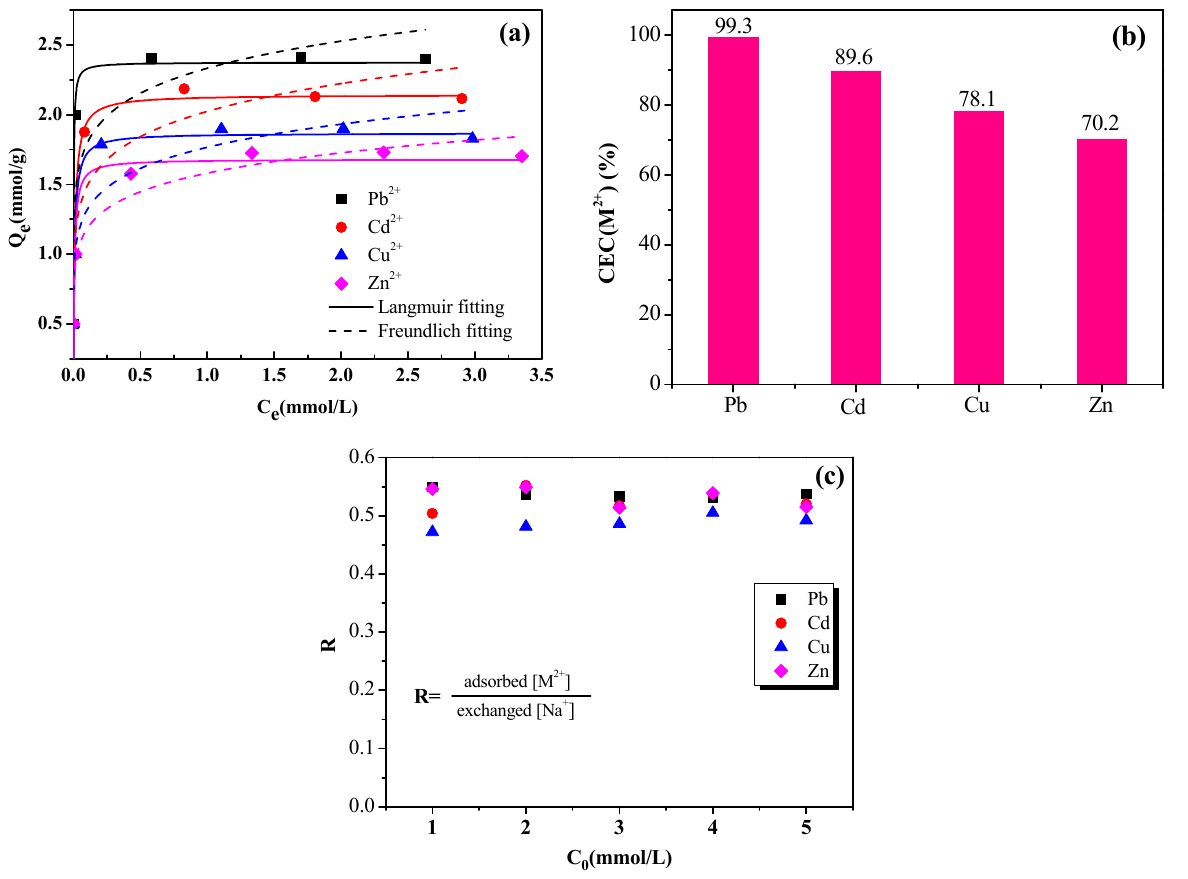
Figure 2. ( a ) NaX adsorption isotherms for Pb 2+ , Cd 2+ , Cu 2+ and Zn 2+ ; ( b ) the M 2+ amounts adsorbed as % of the CEC; and ( c ) the ratio (R) of adsorbed [M 2+ ] to exchanged [Na + ] during the adsorption process. Table 2. Isotherm parameters for Pb 2+ , Cd 2+ , Cu 2+ and Zn 2+ sorption using NaX. Metal Ions